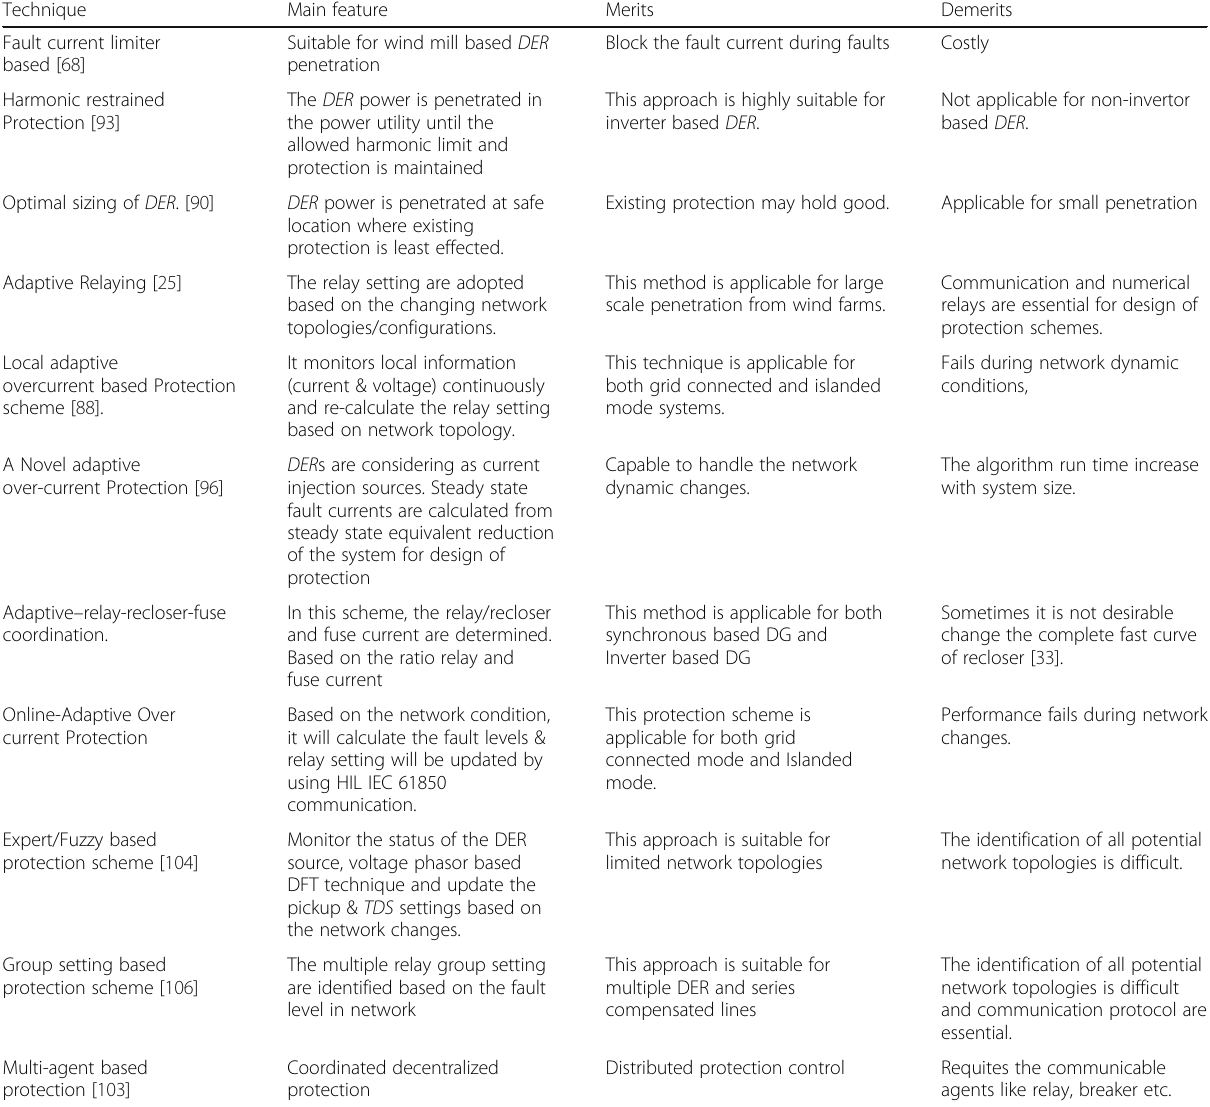
Table 3 Summary of protection schemes for distribution systems with DER Penetration